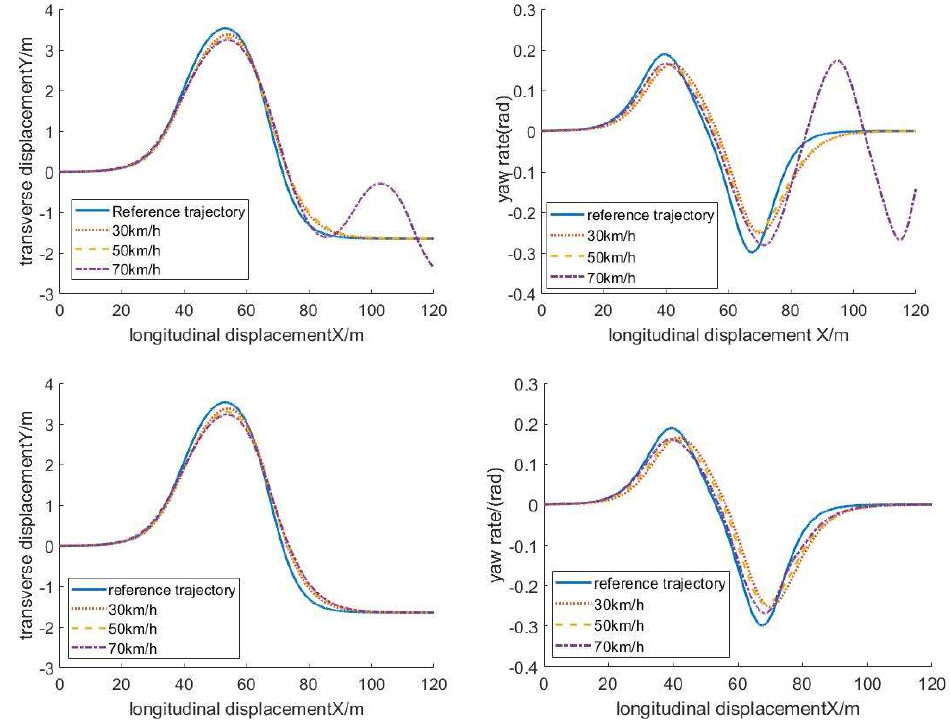
Figure 14. Comparison of vehicle tracking effect.